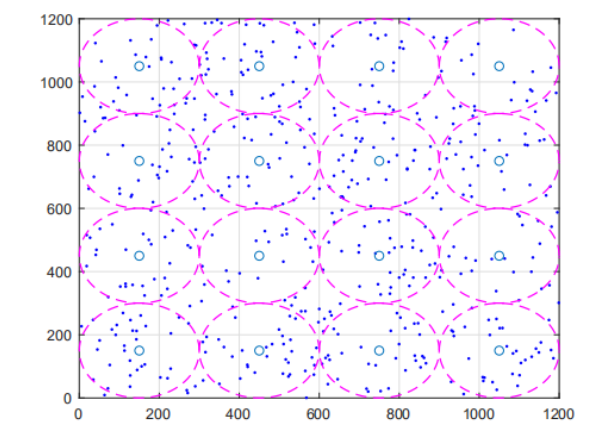
Figure 2. Sample simulated topology with Poisson distributed nodes (density = 0.3 nodes per unit area). The filled squares and dotted circles represent the location and coverage area of PU transmitters